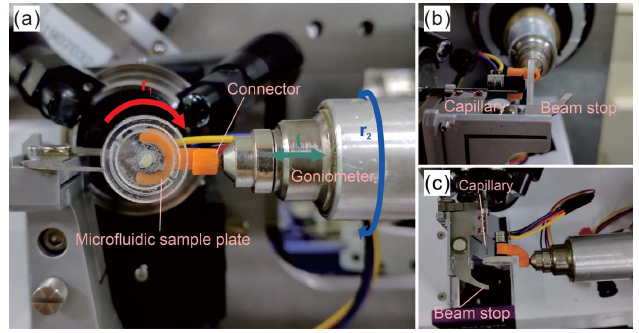
Figure 2 Physical images of the 3-DOF-MRT device and its status when used for the SSX experiment. ( a ) Front view of the 3-DOF-MRT device. The red arrow indicates the rotational ( r 1 ) degree of freedom, the green arrow indicates the translational degree of freedom, and the blue arrow indicates the rotational ( r 2 ) degree of freedom. ( b ) Side view of the 3- DOF-MRT device. ( c ) Top view of the 3-DOF-MRT device.